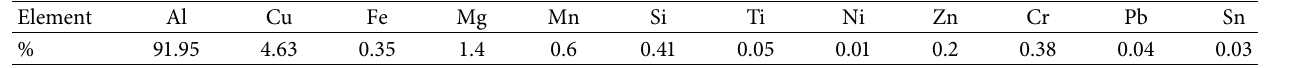
Table 1: Chemical composition of AA2024